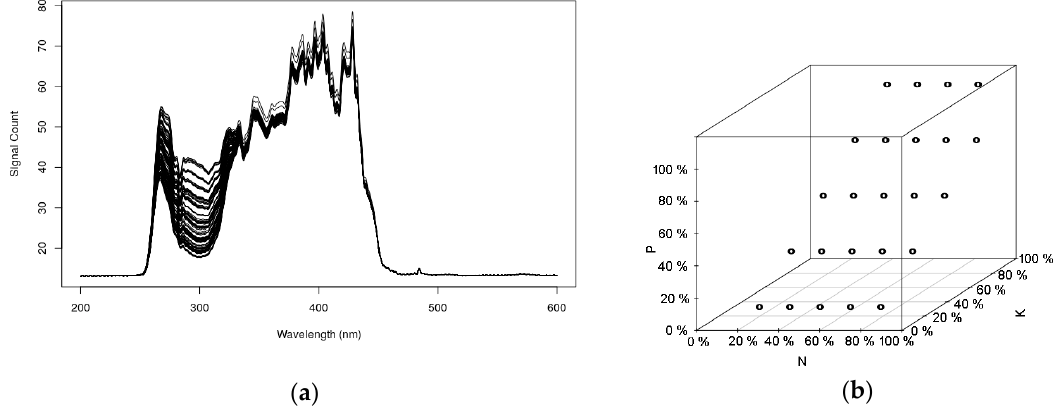
Figure 5. UV-Vis spectra of some nutritional solutions prepared ( a ). Factorial design for the sample emulation assays for N, P, and K nutrients ( b ).